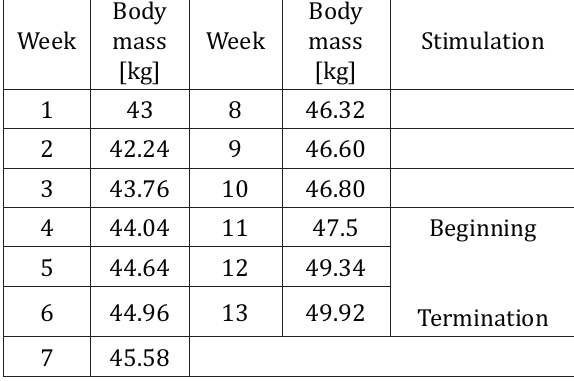
Table 3. Changes in examined factors during tDCS stimulation